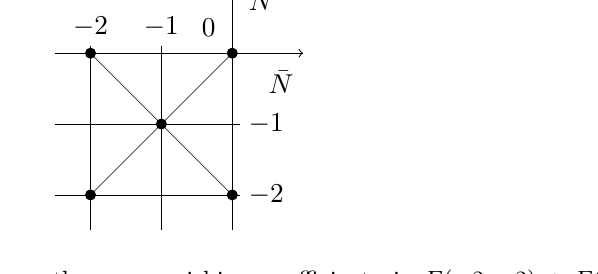
Figure 8 . The only condition on the non-vanishing coefficients is F ( − 2 , − 2) + F ( − 1 , − 1) + G ( − 2 , 0) + G ( − 1 , − 1) = 0